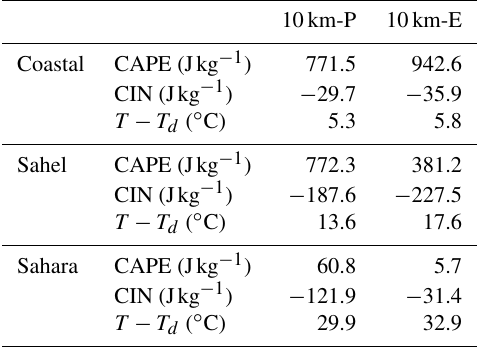
Table A1. The same as Table 1 but for the 10km-P and 10km-E simulations.